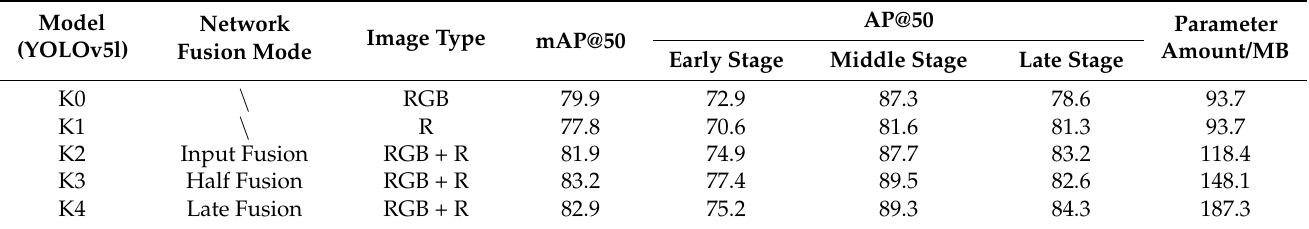
Table 4. Detection performance of different network fusion modes on KP